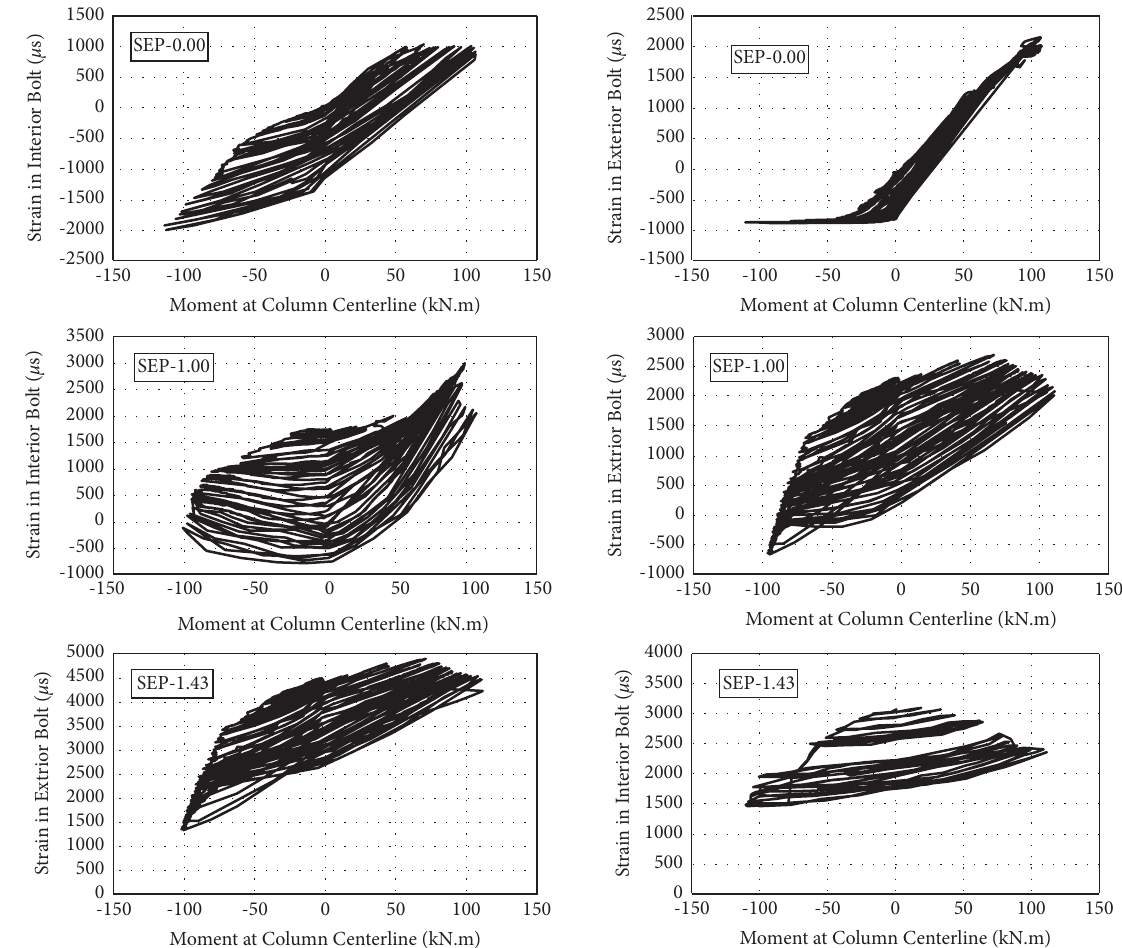
Figure 10: Strain variation history for exterior or interior bolt of the specimens during the loading process.